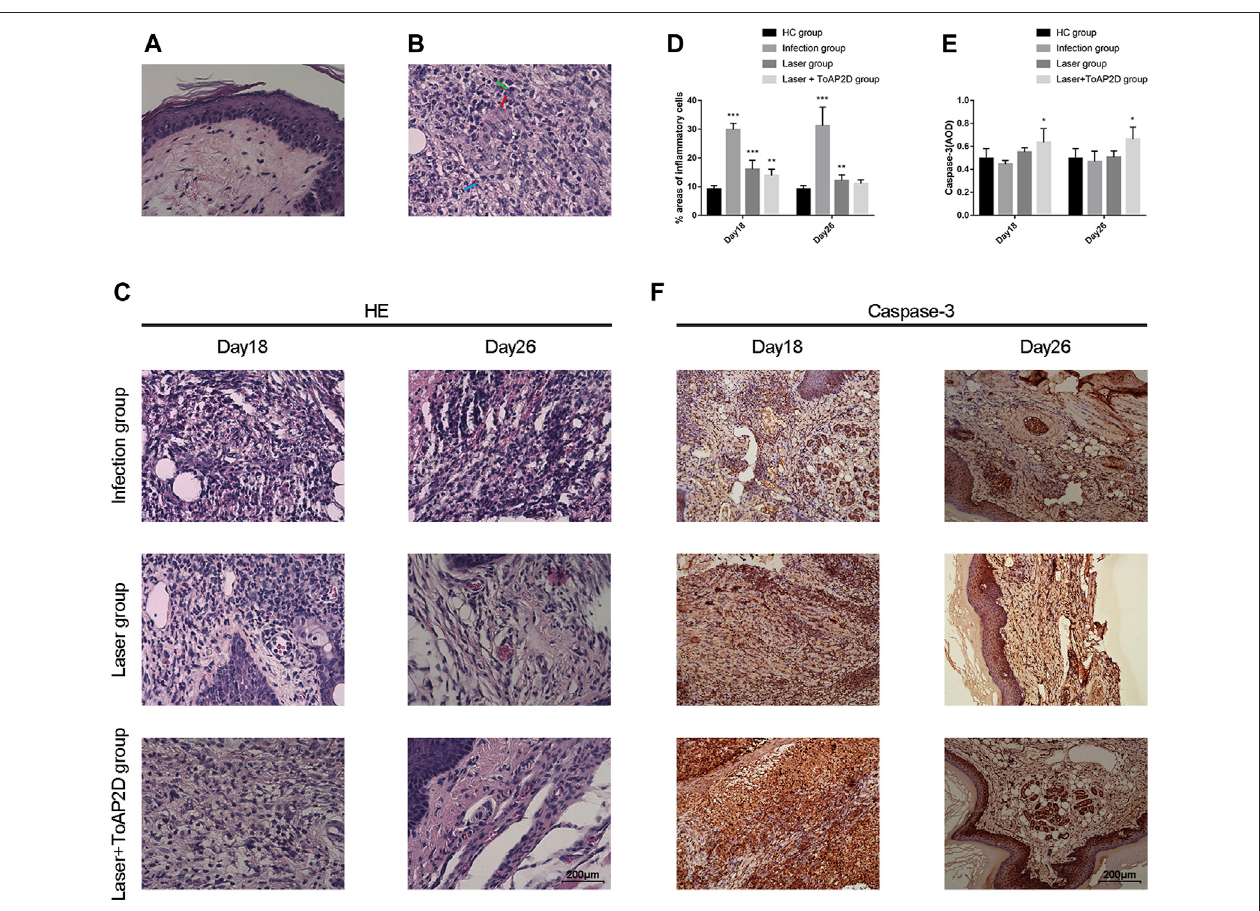
FIGURE 6 | The mice histopathology and IHC comparison after different treatments. We compared the histopathological changes and caspase-3 expression of mice skin tissues on Day18 and 26. (A) HC group. (B) Study group on Day 10 (red arrow: epithelioid cell, green arrow: mononuclear cell, blue arrow: neutrophil). (C) Histopathologicalchangesofmiceskin tissuesafter differenttreatments onDay18and 26. (D) Compared withHC,thepercentage areaofin fl ammatorycellsindifferent treatment groups on Day 18 and 26, respectively. (E – F) Compared with HC, the IHC expression of caspase-3 in different treatment groups on Day 18 and 26,